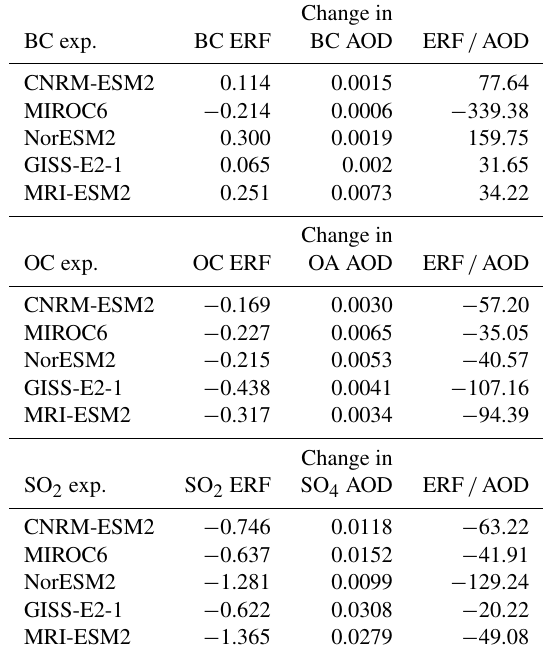
Table 4. Values of ERF, (cid:49) AOD and ERF / AOD for aerosol